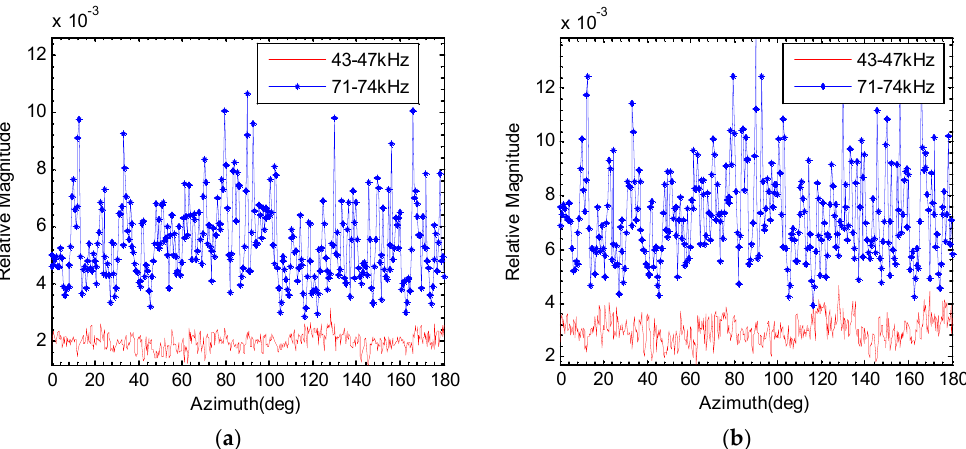
Figure 13. ( a ) Fluctuation intensity comparison of the rock echo envelope with different frequencies; ( b ) STD comparison of the rock echo envelope fluctuation intensity with different frequencies.